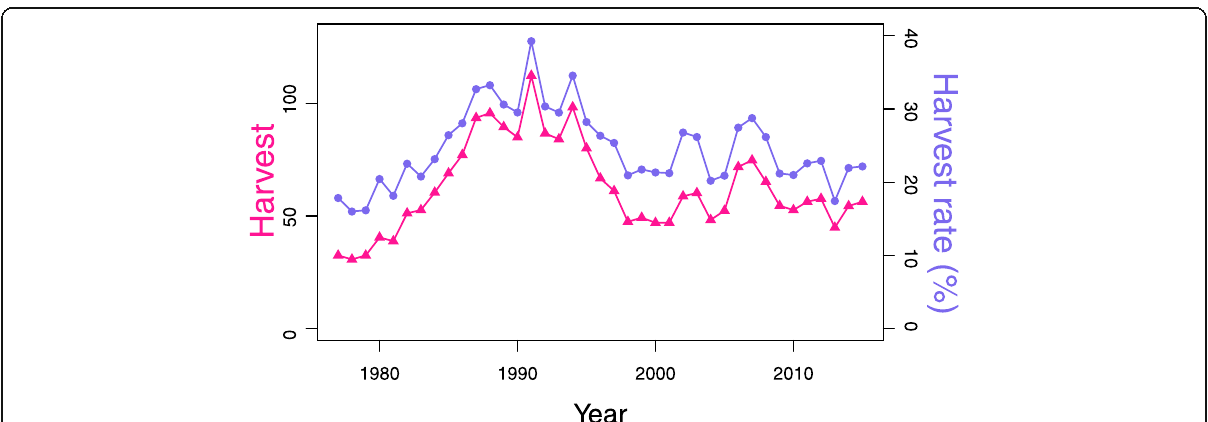
Fig. 3 Reindeer harvest in Sweden 1977 – 2015. Time series of the number of reindeer harvested in Sweden (left y -axis and pink triangles) and harvest rate (right y -axis and violet dots). The number of harvested reindeer was calculated as the percentage of harvested reindeer out of the total number of animals in the previous-year